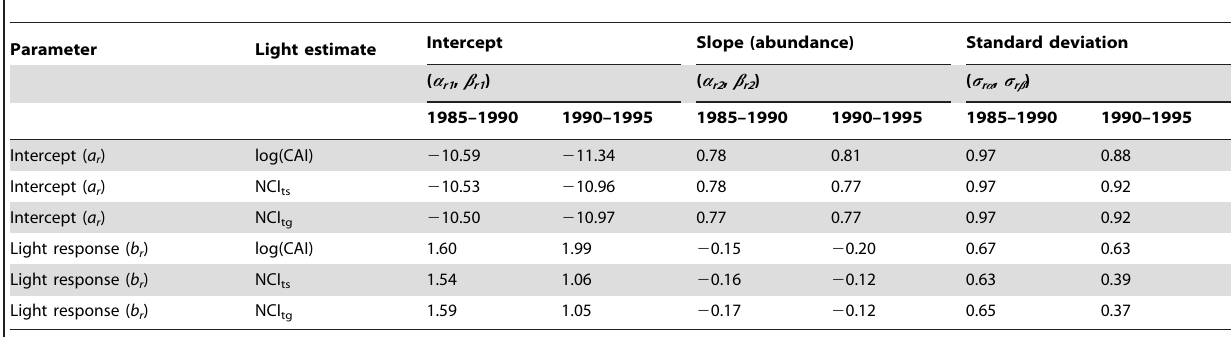
Table 2. Posterior estimates of hyperparameters for the species-specific parameters of the recruitment model.